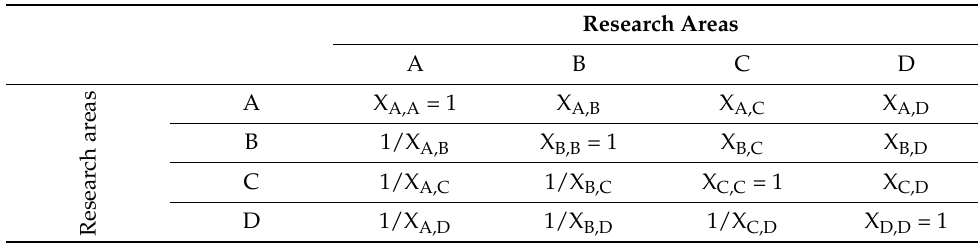
Table 2. Questionnaire matrix for research area prioritization. Source:Own elaboration based on Satty